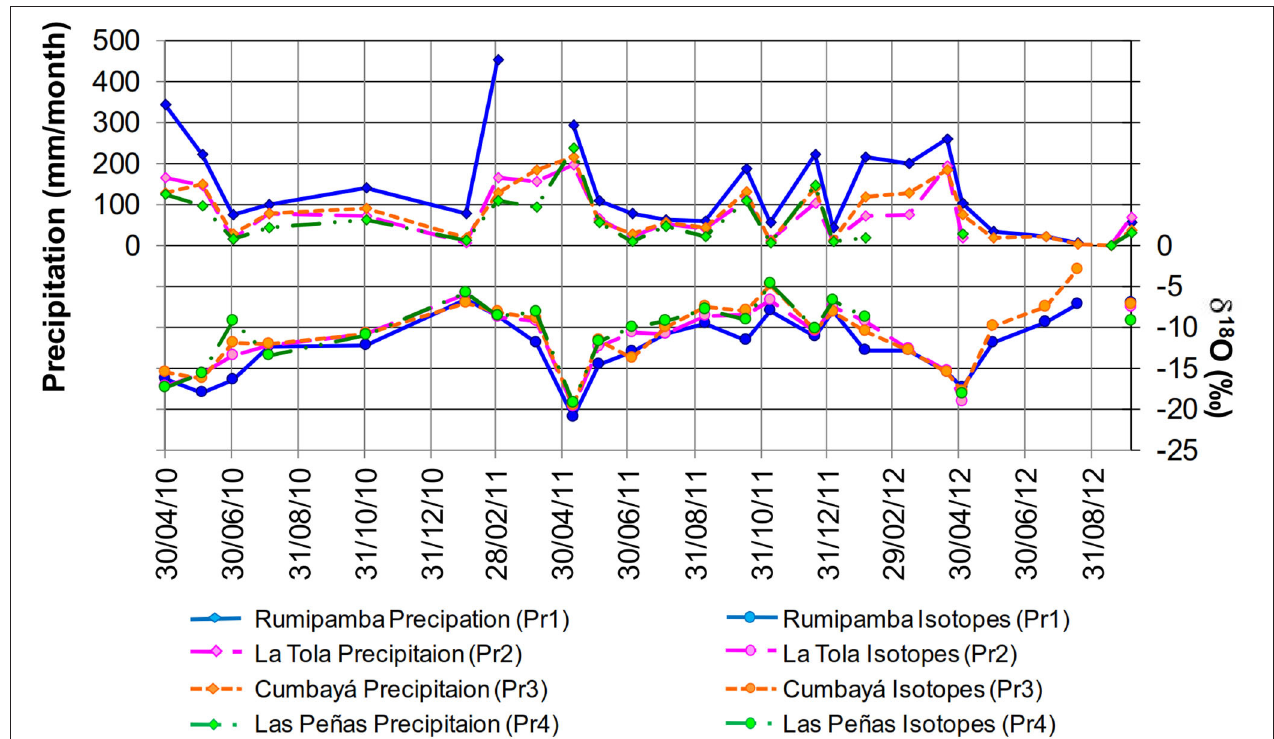
FIGURE 7 | Monthly variation of rainfall (top) and rainwater δ 18 O (bottom) in the four surveyed stations.